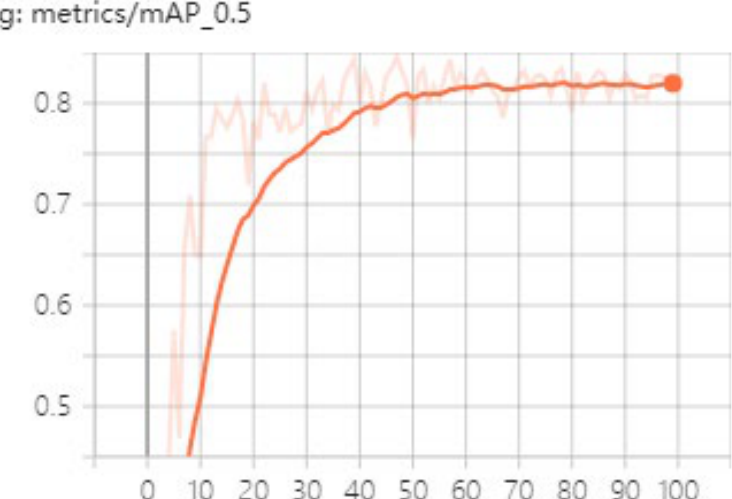
Figure 13. Average precision curve.